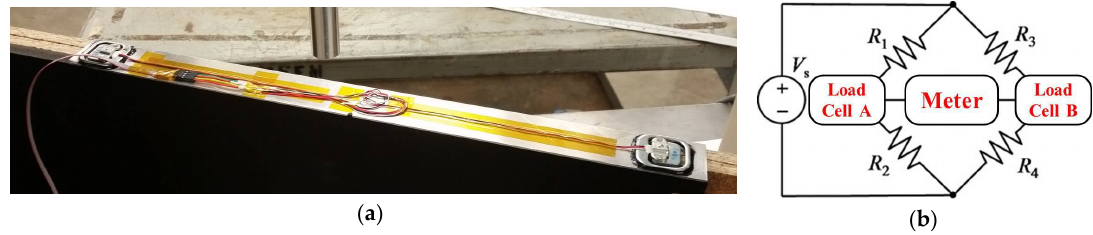
Figure 2. ( a ) The Load Sensing Beam, ( b ) The Wheatstone bridge circuit